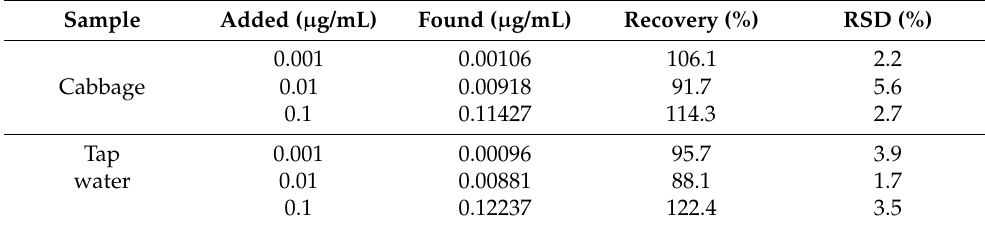
detecting ICP in cabbage and tap water